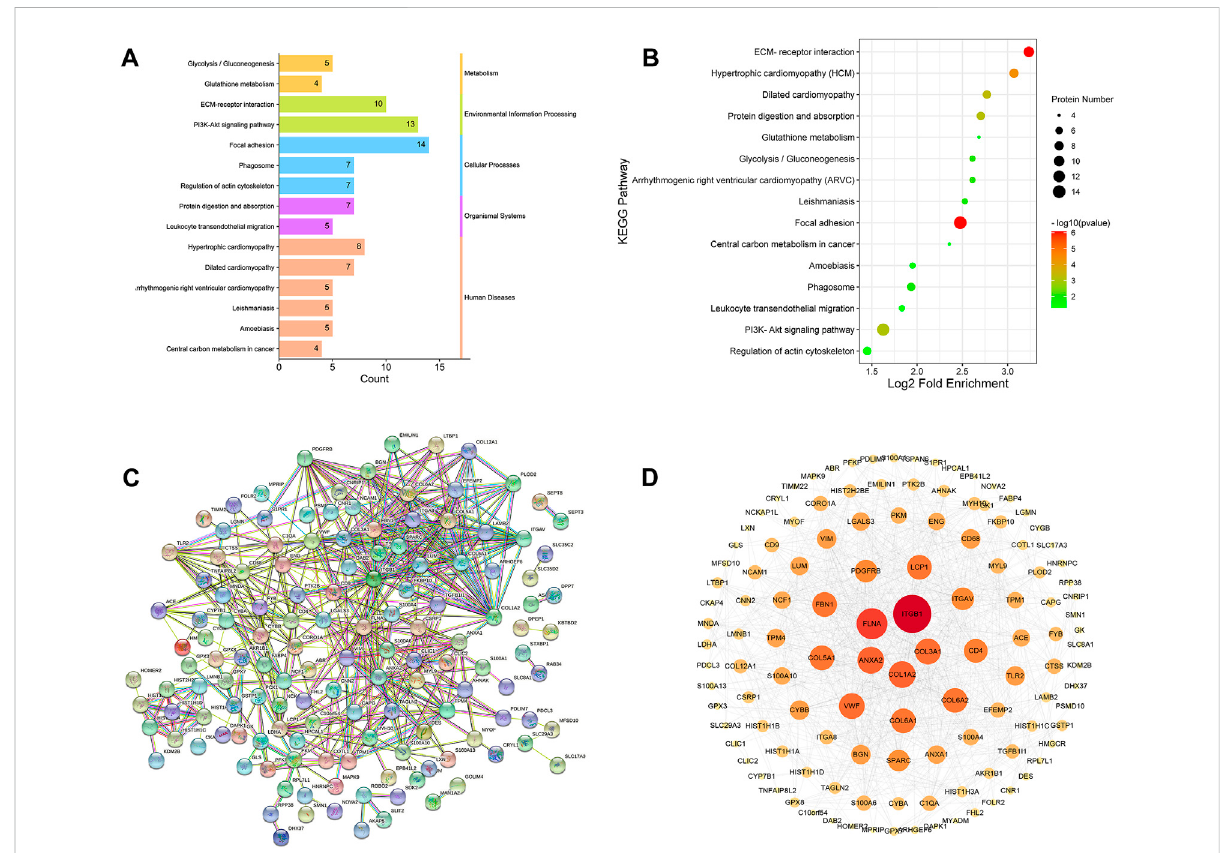
FIGURE 8 Kyoto Encyclopedia of Genes and Genomes (KEGG) pathway analysis and protein-protein interaction (PPI) network analysis of DEPs. (A) Classi fi cation of KEGG pathways. (B) Enrichment bubble plots of DEPs in the KEGG pathway, p < 0.05. (C) PPI analysis among the DEPs of STRING database, medium con fi dence > 0.4. (D) Cytoscape analysis of DEPs.